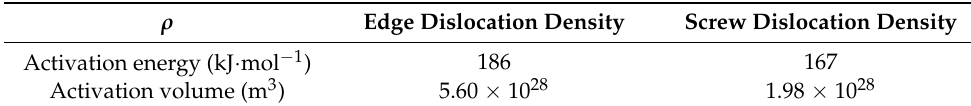
Table 2. Estimated values of activation energy and activation volume at 623 K when ρ in Equation (12) is assumed to be edge- or screw-dislocation density.